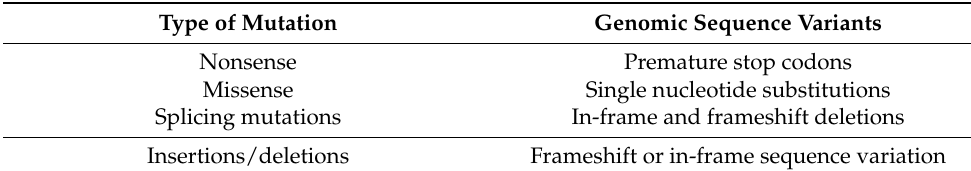
Table 3. Genomic variants (mutations) resulting in various types of OI.